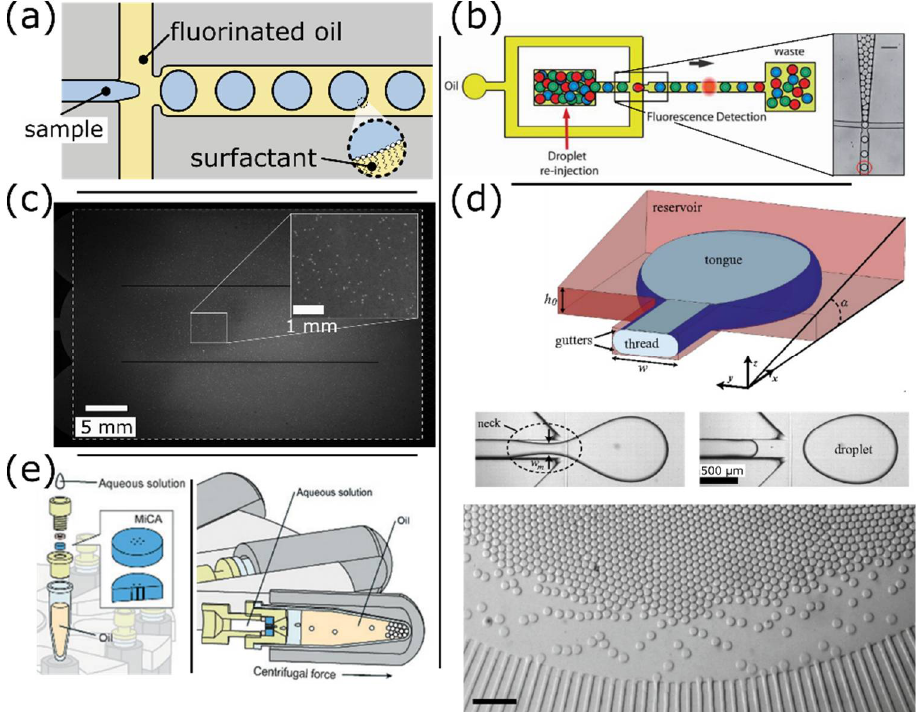
Figure 9. Microfluidic droplet-based platforms. ( a ) Schematic illustrating the generation of droplets with a nozzle or droplet generator. The aqueous phase is pinched by two streams of immiscible oil that stretch the interface via viscous forces until a capillary instability develops and the droplet detaches. Droplets are very stable thanks to surfactants that stabilize their interface; ( b ) The fluorescence signal from droplets can be sequentially detected in a single-file configuration. This arrangement is reminiscent of the optical and fluidic configurations used in flow cytometry. (Figure adapted from [86] with permission.); ( c ) Droplet signal can also be interrogated using a wide field detection that allows up to 1 million droplets to be analyzed simultaneously (Figure adapted from [43] with permission.); ( d ) Microfluidic droplets can be generated with a simplified experimental setup that relies on a gradient of confinement (a type of step emulsification). (Figure adapted from [87] with permission.); ( e ) Alternatively, highly parallel droplet generators have been adapted to actuation by centrifuge, which allows concurrent encapsulation of several samples. Scale bar: 500 µ m. (Figure adapted from [88] with